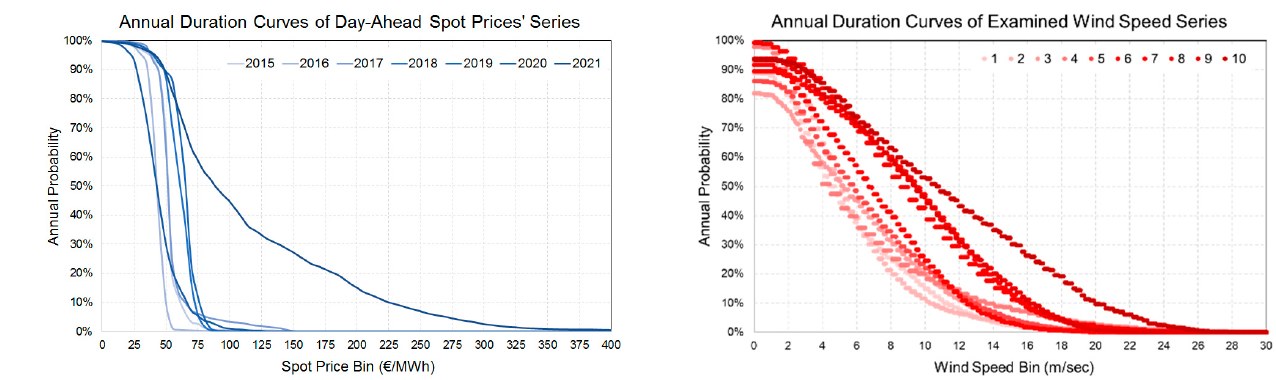
Figure 2. Duration curves of electricity spot price years and wind speed regimes.